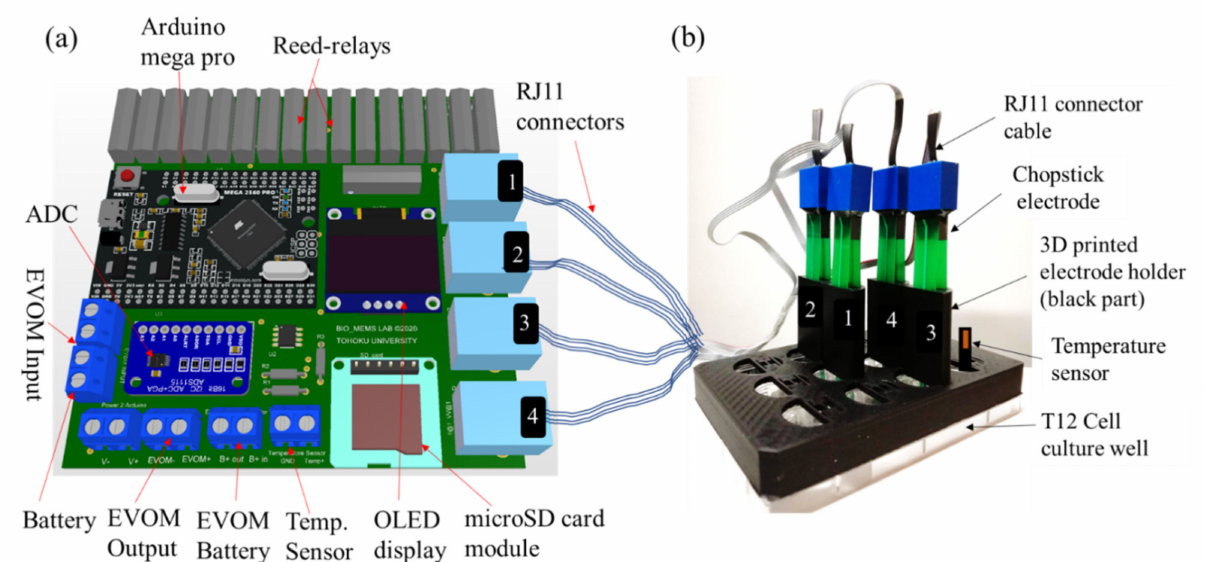
Figure 3. Add-on device with 3D printed electrode holder. ( a ) Printed circuit board (PCB) with electrical components of the add-on device. ( b ) Chopstick electrodes placed securely in the 3D printed electrode holder (showing 4 samples) and temperature sensor (wiring not shown). The add-on device was kept outside the cell culture incubator whereas the samples and the device were placed inside and connected through a flexible